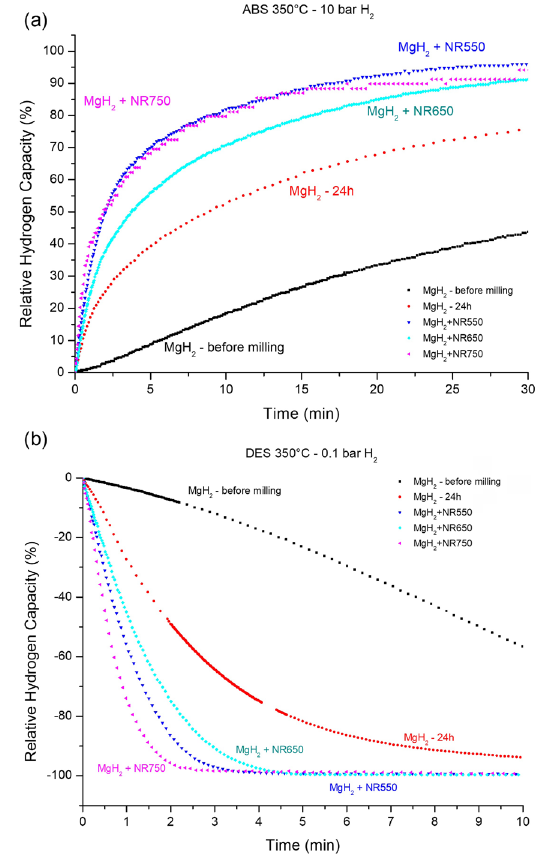
Figure 7. Normalized hydrogen absorption (a) and desorption (b) kinetic curves at 350 ºC for samples of MgH +NR750(e,f), 2